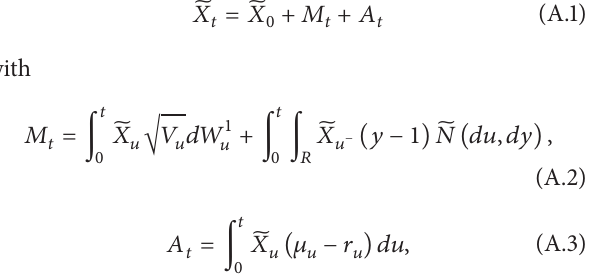
Figure 2: The American option price.